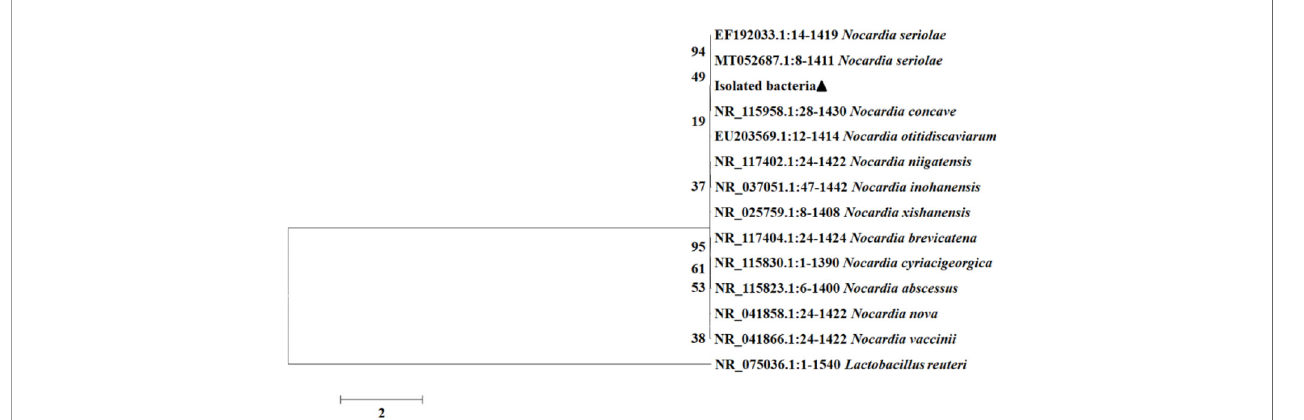
FIGURE 2 | Phylogenetic analysis of 16S rDNA from the isolated bacteria, N. seriolae and other Nocardia sp. The phylogenetic tree was constructed using MEGA 6.0 with the Mmaximum likelihood method. Numbers of each node indicate the percentage of bootstrapping in 100 replications.